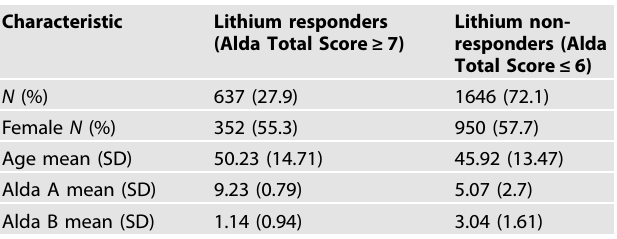
Table 1. Characteristics of the patient sample.